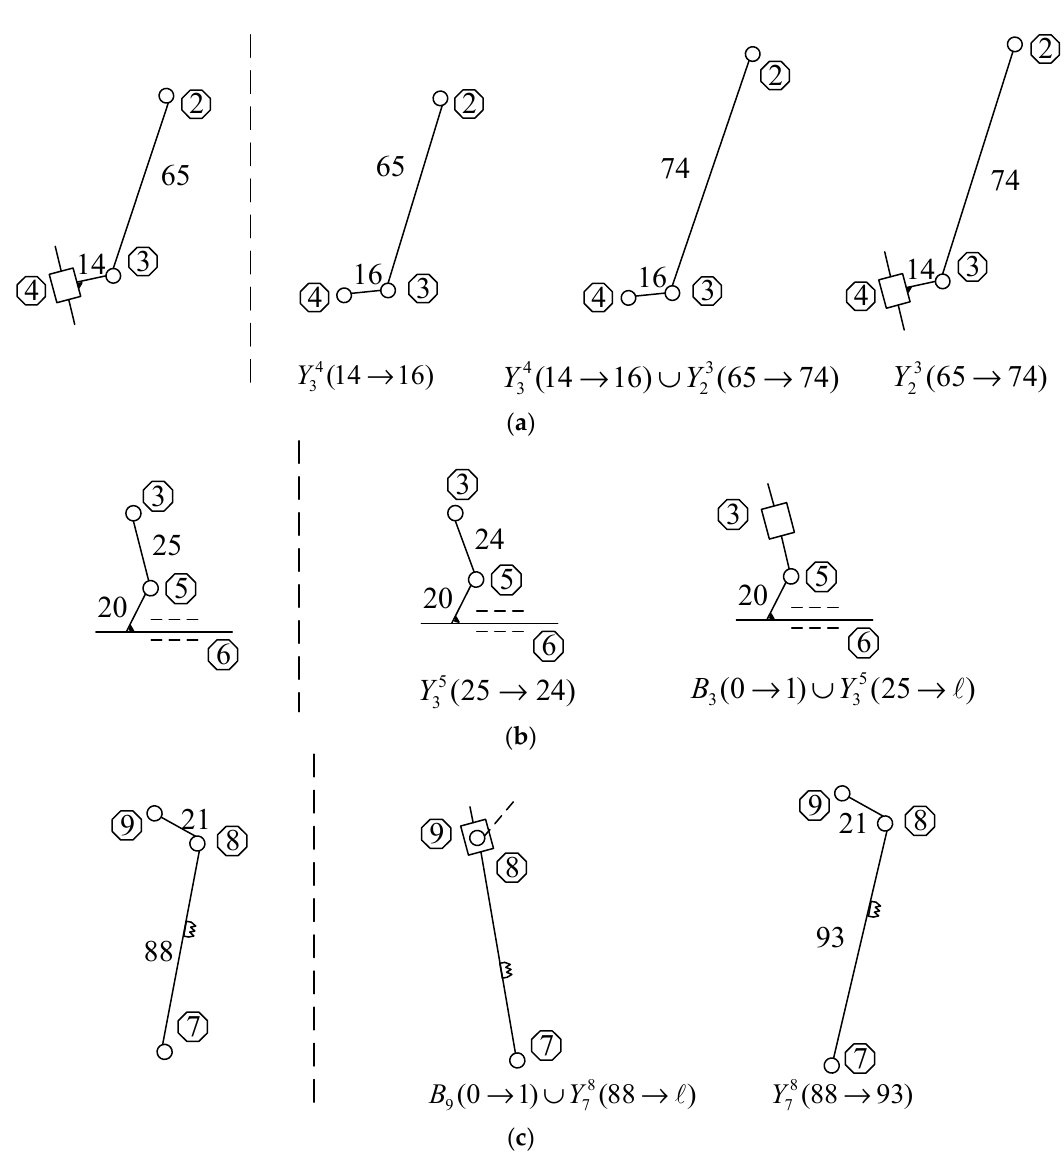
Figure 11. Configuration scheme sets of each metamorphic element of the feed mechanism. Configuration set of metamorphic ( a ) element 1, ( b ) element 2, and ( c ) element 3.